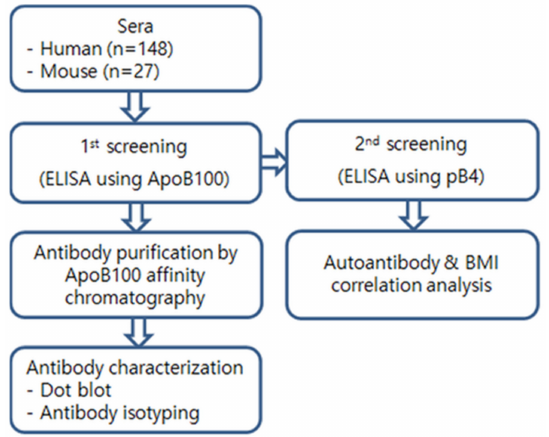
Figure 4. Strategy of serum analyses. The color reaction was performed with o -phenylenediamine dihydrochloride for 10 min at 37 ◦ C, and the absorbency (450 nm) measured to calculate the antibody titer. Human ApoB100 was purchased from Sigma (A5353, Sigma). Because of high background values especially of the human sera, we used a two-stage ELISA screening procedure (Figure 4) in order to discriminate true from false positive signals. In the first screening stage, we used 100-fold diluted sera with human ApoB100 as analyte (Supplementary Figure S2A). In the second screening step, the sera were serially diluted 100-, 200-, 400-, and 800-fold and pB4 used as analyte. Samples were considered as positive when they